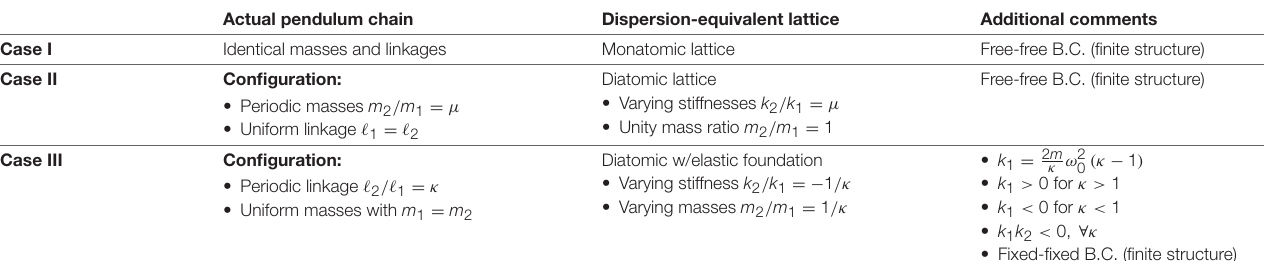
TABLE 1 | A summary of the considered periodic pendulum chain cases and their equivalent PC lattice with the presence of a payload mass.